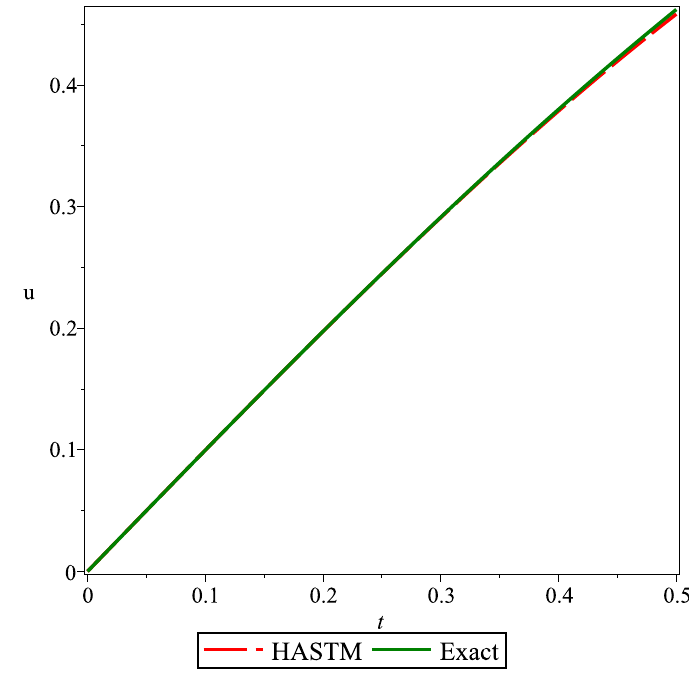
Figure 7. Plot of u ( t ) with respect to t for µ =